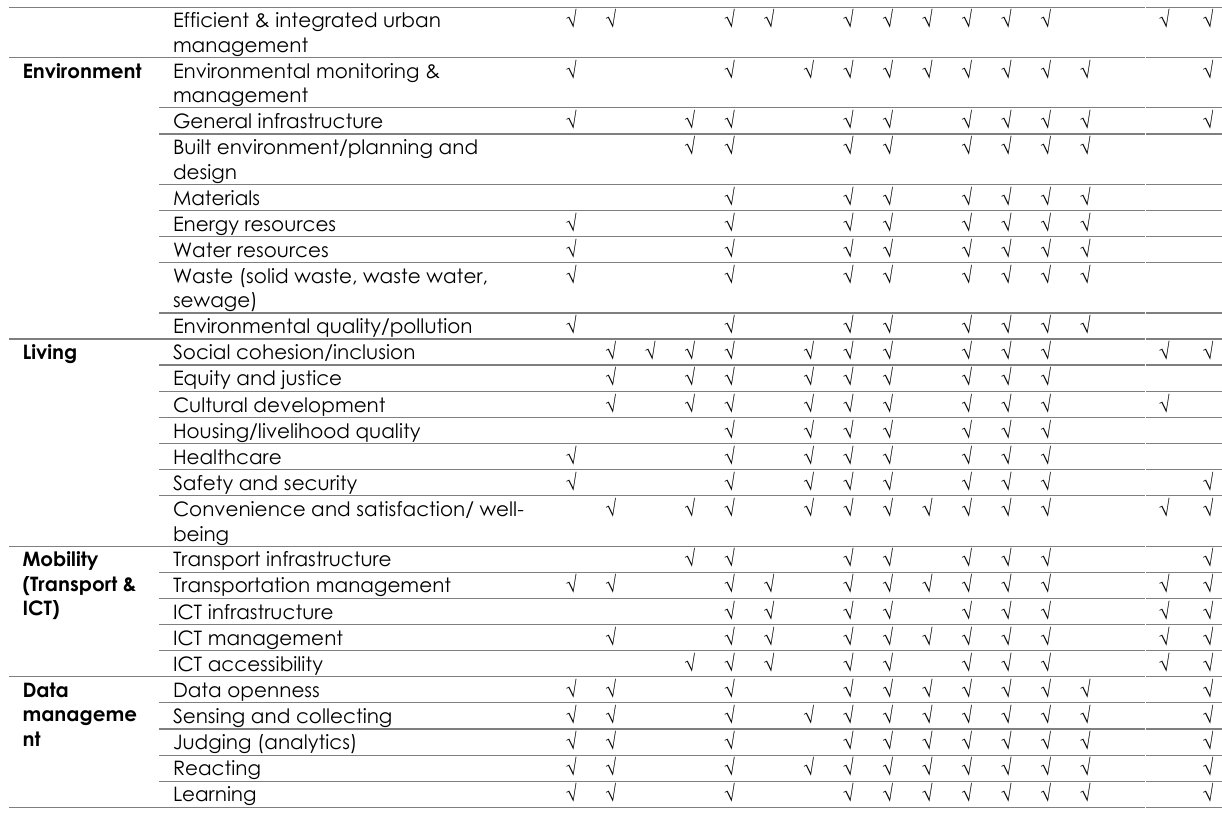
Table 4. Themes and Sub-themes of the reviewed papers in Urban Literature (continued). Sharifi (2019) Assessment Tools & KPIs for Smart